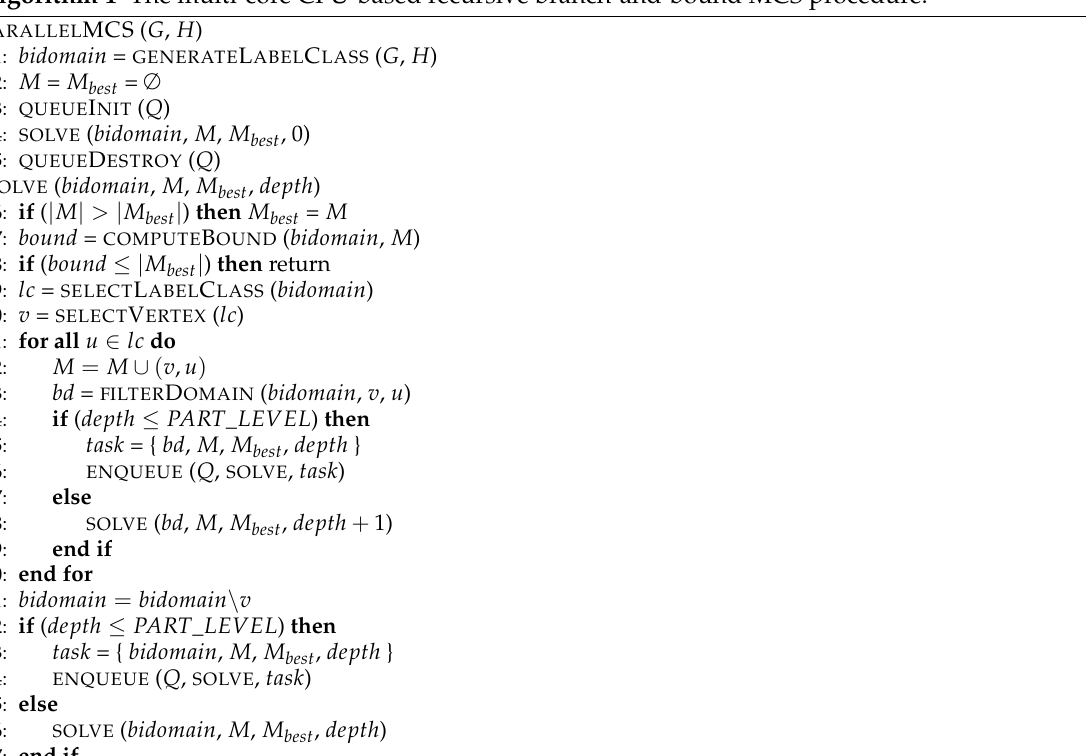
Algorithm 1 The multi-core CPU-based recursive branch-and-bound MCS procedure. PARALLEL MCS ( G , H